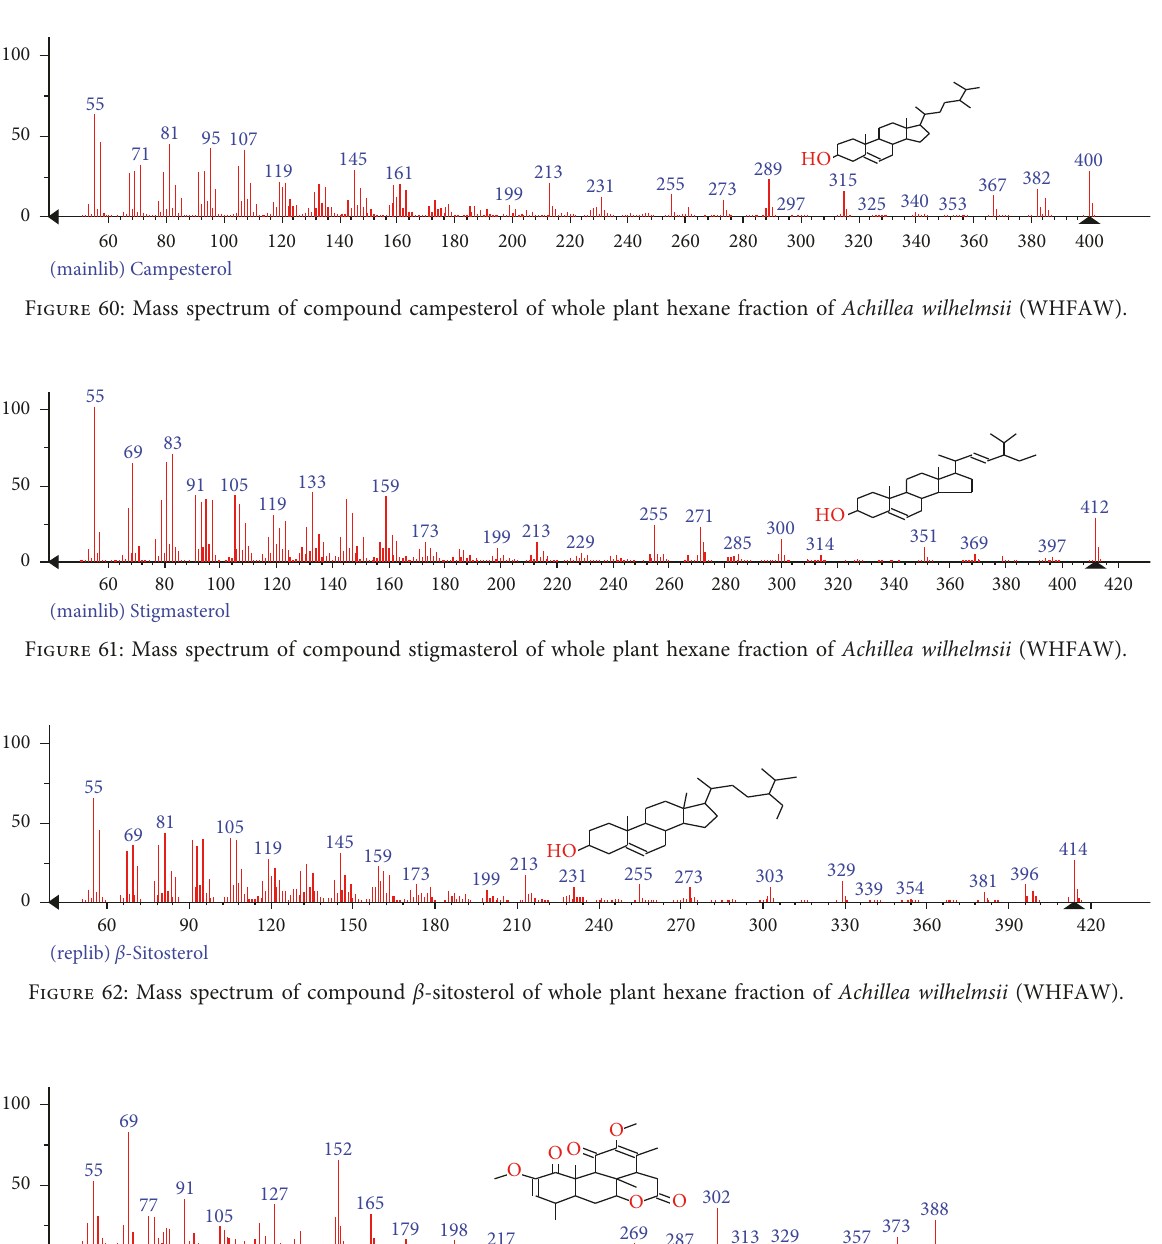
)-60 (mainlib) Pregnan-20-one, 3-(acetyloxy)-5,6:16,17-diepoxy-, (3 β ,5 α ,6 α ,16 α Figure 59: Mass spectrum of compound pregnan-20-one, 3-(acetyloxy)-5,6:16,17-diepoxy-, (3 β ,5 α ,6 α ,16 α )- of whole plant hexane fraction of Achillea wilhelmsii